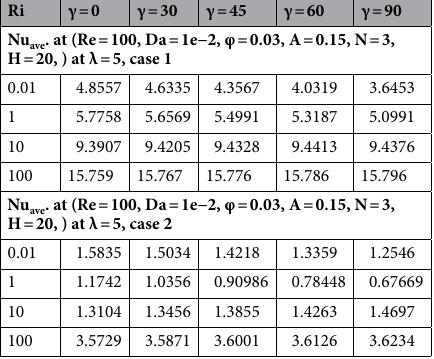
Table 15. Comparison of average Nu for Case 1 and Case 2 at different Ri and γ.